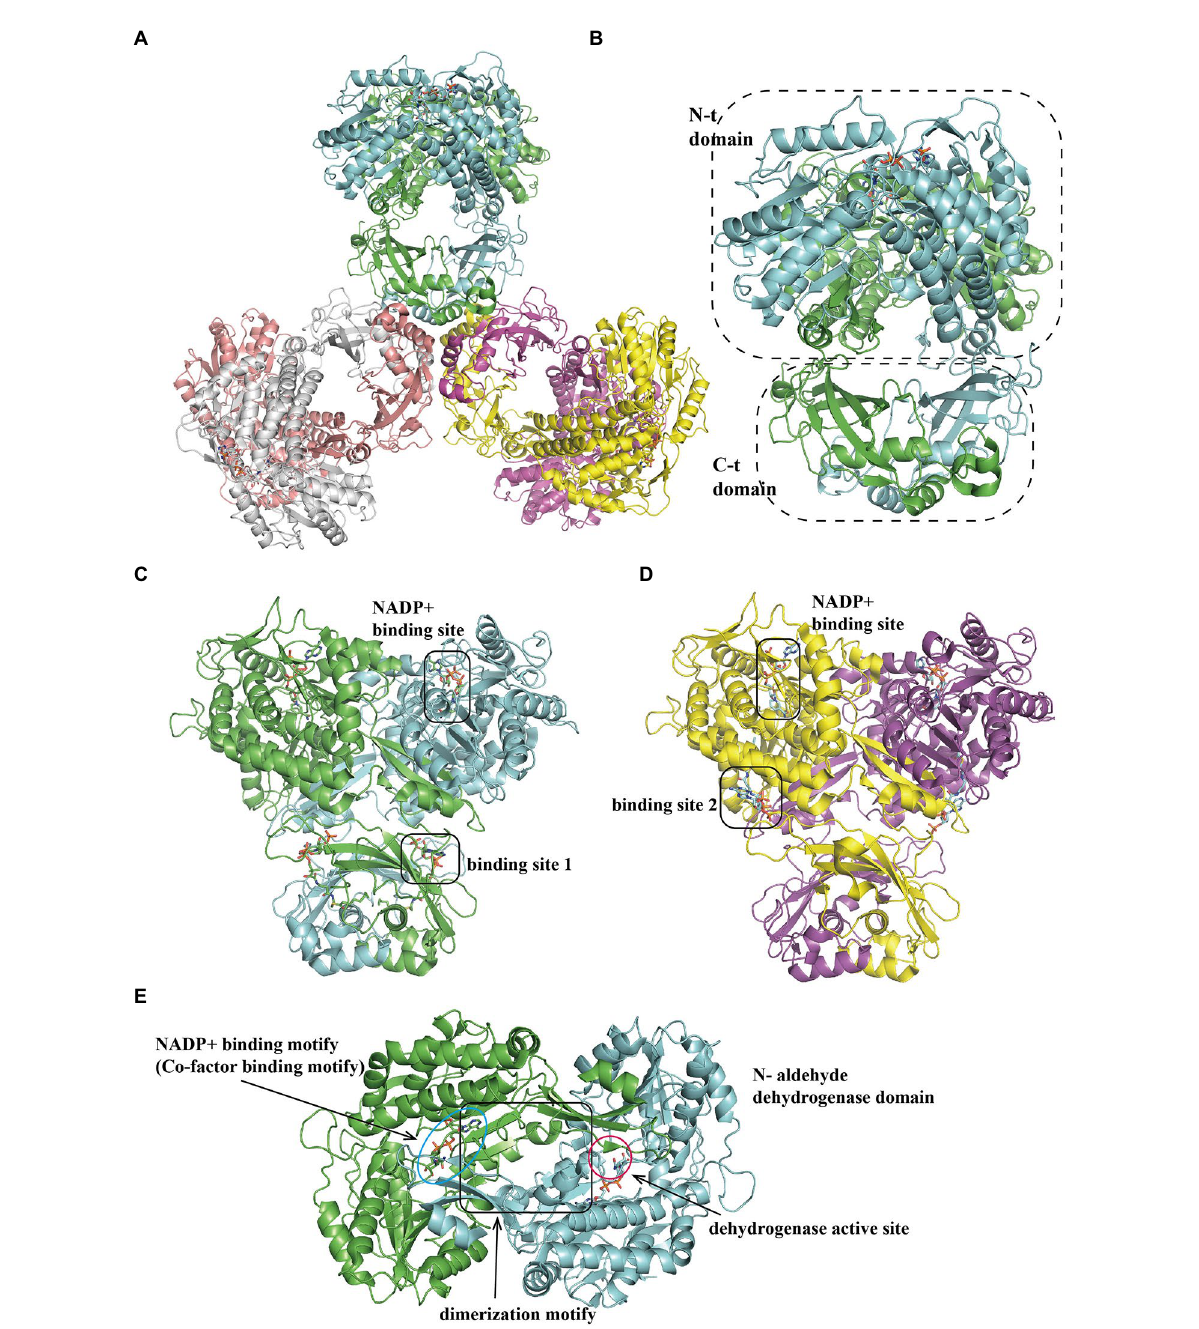
FIGURE 6 Overall structure of PaaZ. (A) The overall structure of the tri-lobed architecture hexamer EcoPaaZ (PDB:6JQM) is shown in different colors for each chain. The architecture unit PaaZ dimer reveals an N-terminal aldehyde dehydrogenase domain and the C-terminal R-specific hotdog fold hydratase domain, circled with a dotted line. For clarity, in the substrate binding domain, the rotated views from (A) are shown in (B) with OCoA (PDB:6JQN) and with CCoA (PDB:6JQO; C ) in different binding site 1 or 2, respectively. The NADP + -binding site is the same in (B) and (C) . (D) The N-terminal dehydrogenase domain can be divided into three sub-domains: co-factor binding, catalytic and dimerization motif, shown with lines and annotation,